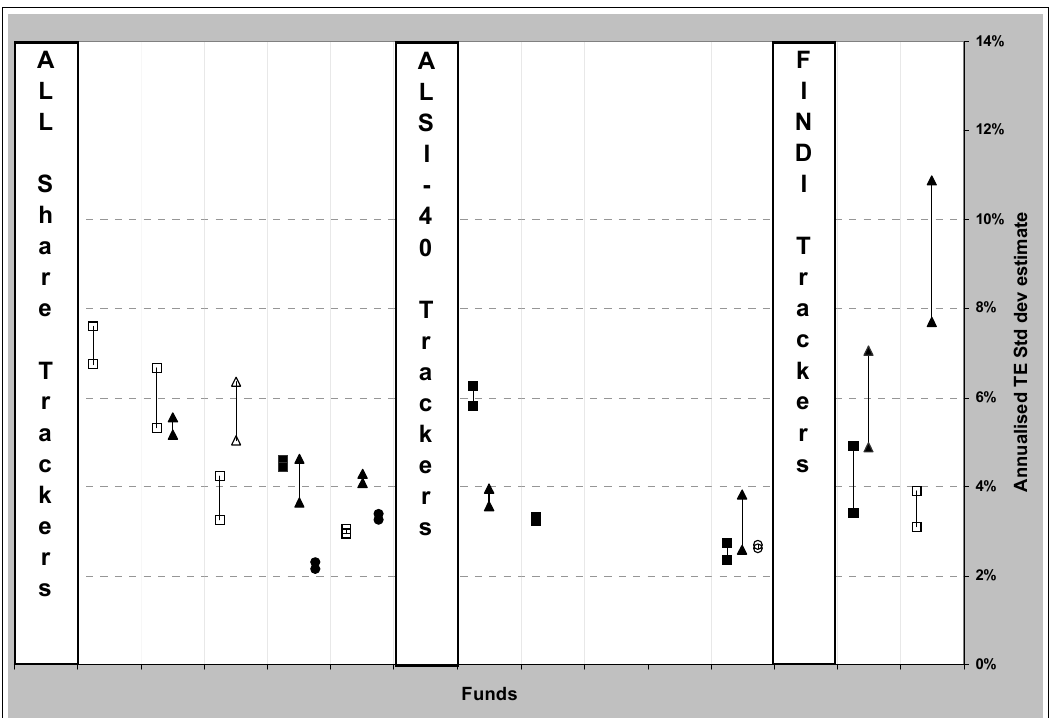
Figure 2: The Lo-MacKinlay Adjustment of Monthly Annualised Estimates of TE Standard Deviation for non-overlapping 25 month